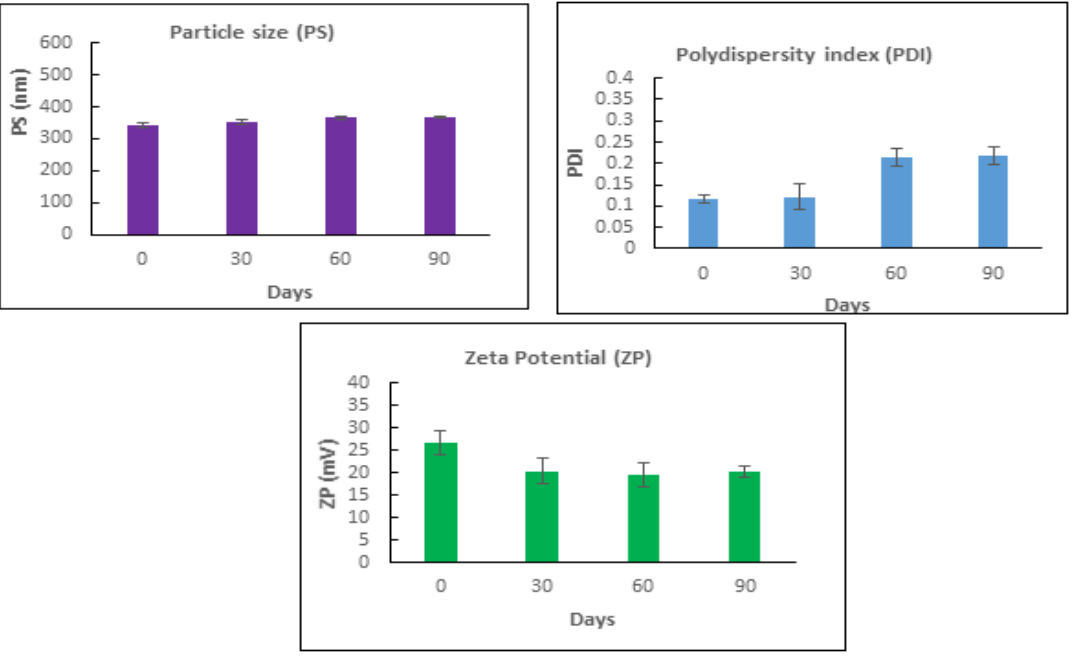
Figure 5. Bar diagrams of the results of storage stability studies of CS coated RES-PLGA NPs at 4 °C for 90 days in phosphate-buffered saline pH 7.4.